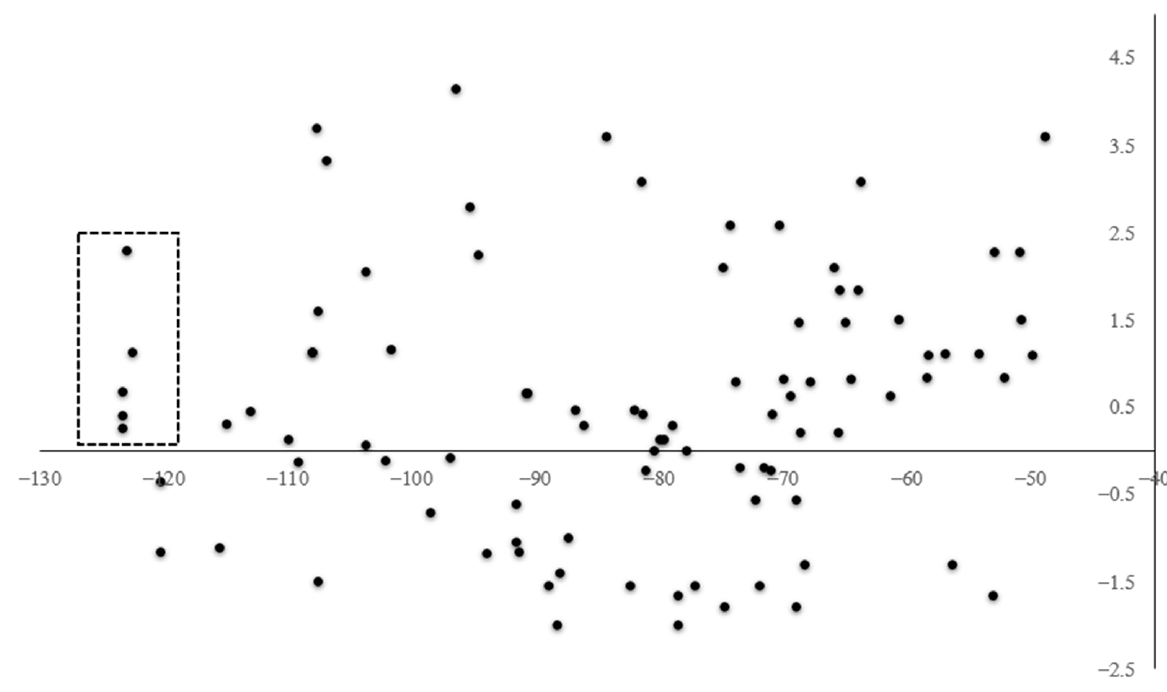
Figure 12. Moldock score (kcal/mol, x-axis) vs. aLogP (y-axis). The marked region indicates the final candidates.